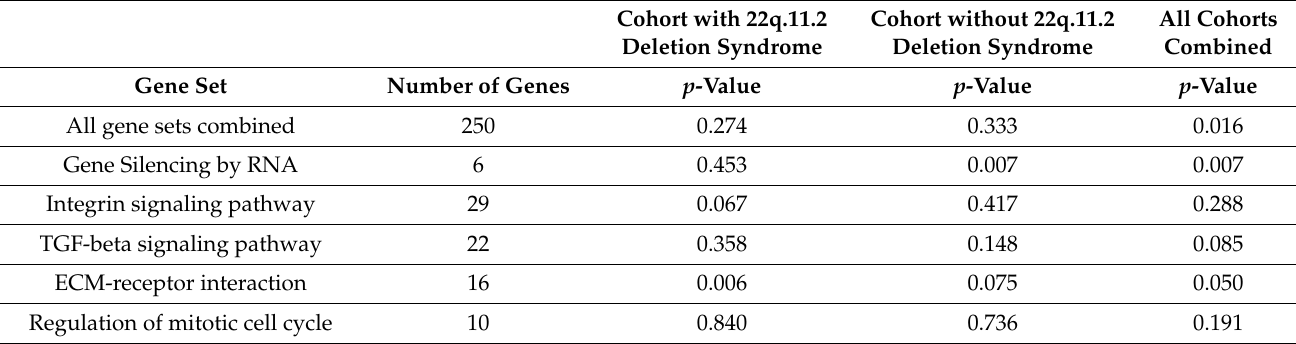
Table 2. Gene set analysis results for 14 gene sets from the rCNV-derived unique gene networks (including all gene sets